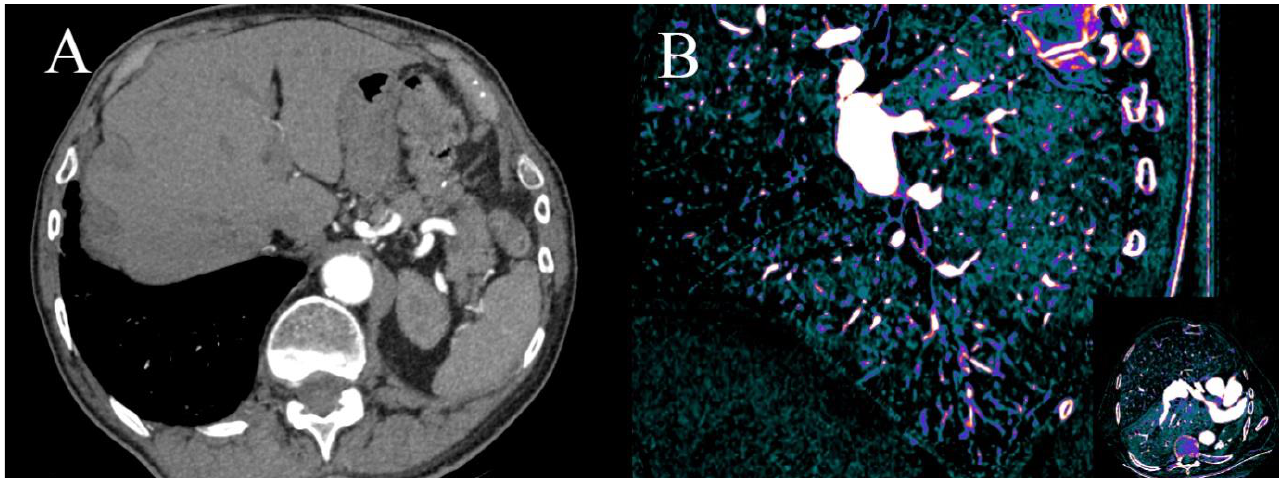
Figure 9. Dual-energy coronary CTA performed due to worsening of dyspnea and suspected CAD. There is small clot in peripheral artery in segment 9 of right lung which can be easily misted in axial VMI at 70 keV ( A ). There is a large V-shape aerial of hypoperfusion visible in sagittal reformat on iodine(water) map in segment 9 ( B ); similar aerials were discovered in segments: 4R and 5R. Finally, diagnosis of chronic peripheral pulmonary embolism was made.